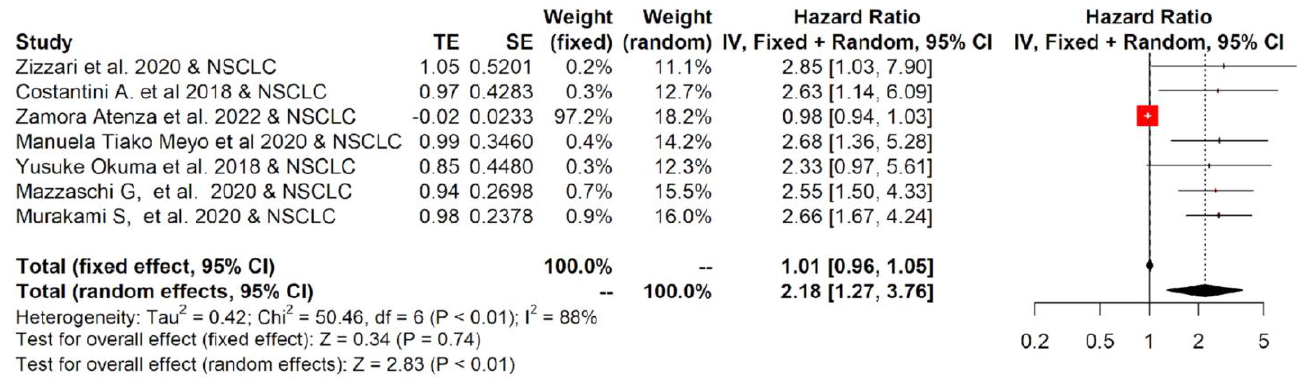
Figure 5. Overall pooled HRs comparing the high- versus the low-PD-L1 values group for PFS in NSCLC patients treated with immunotherapy. The column study indicates the reference (from which we extracted or calculated the HR and 95% CI) and the investigated tumor type [21 – 27].